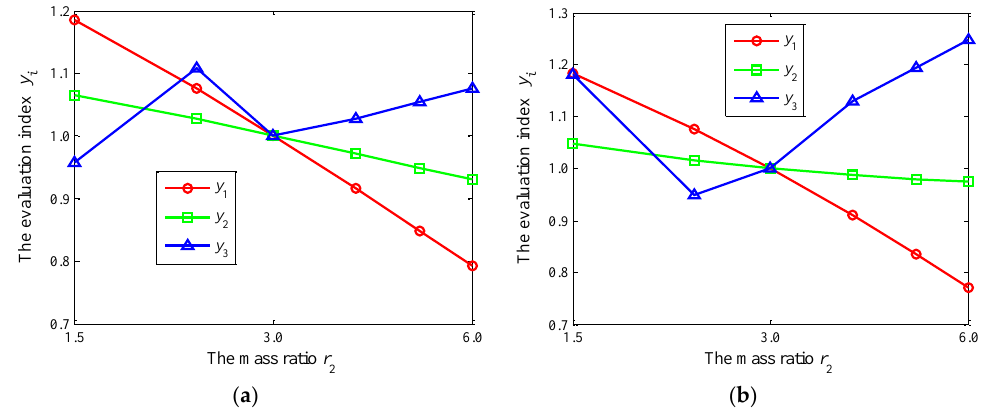
Figure 14. The evaluation index y i versus the mass ratio r 2 for the wheelchair: ( a ) going up the step; ( b ) going down the step.